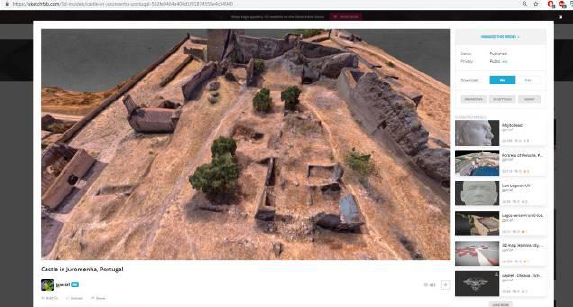
Figure 9. Global low-res photogrammetric model in the Sketchfab platform.